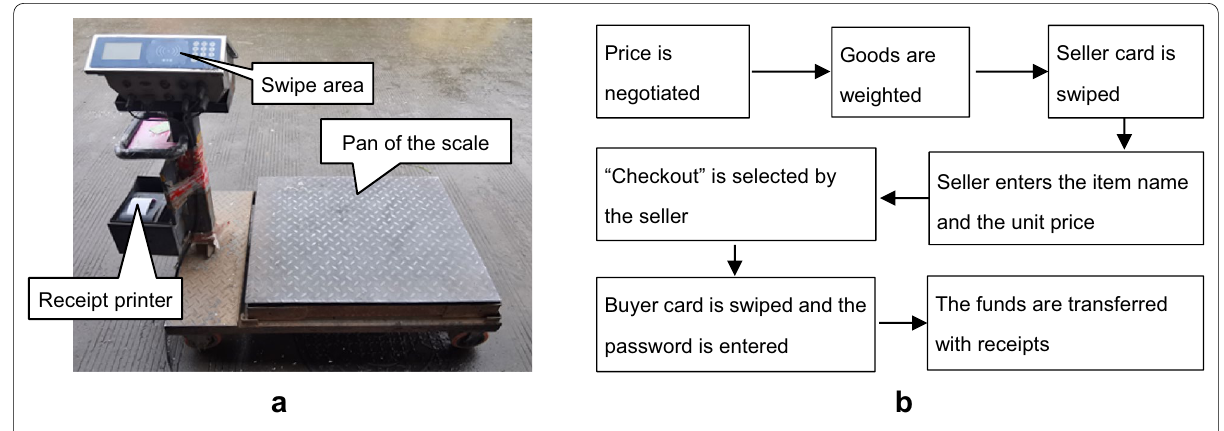
Fig. 1 The self-assistant terminal and flow diagram of using e-transaction